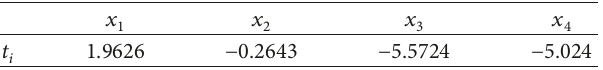
Table 4: Test statistics 𝑡 𝑖 .